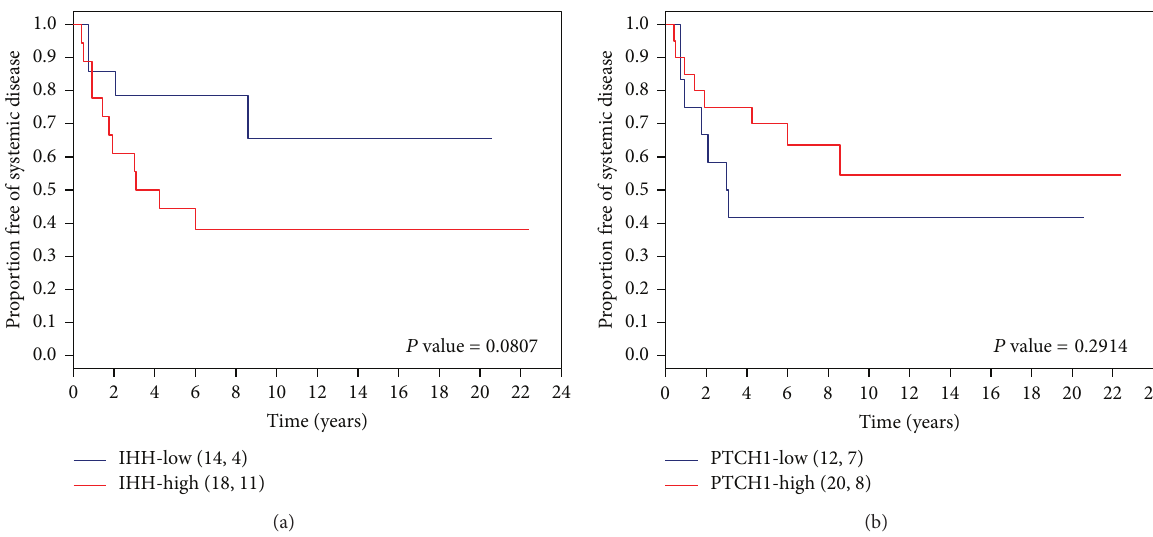
Figure 2: Kaplan-Meier survival curves of systemic disease-free survival for patients without metastasis at diagnosis with high and low levels of (a) IHH and (b) PTCH1 gene expression. 𝑃 value = Log-Rank 𝑃